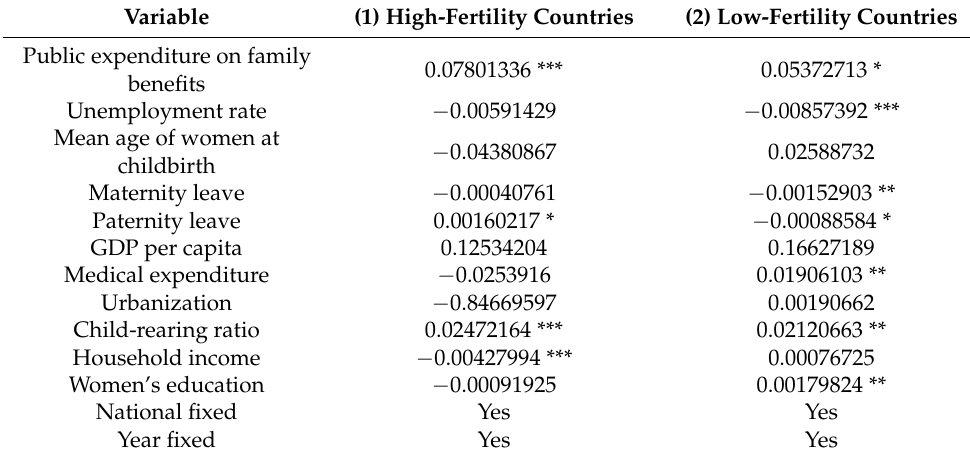
Table 6. Heterogeneity analysis